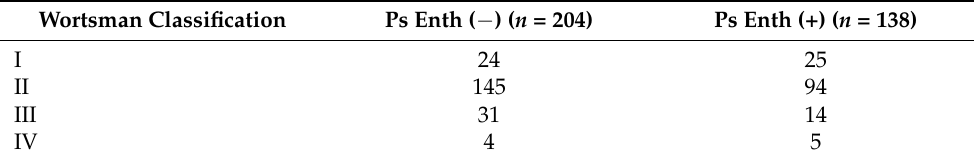
Table 2. Wortsman classification of the psoriatic nails studied.